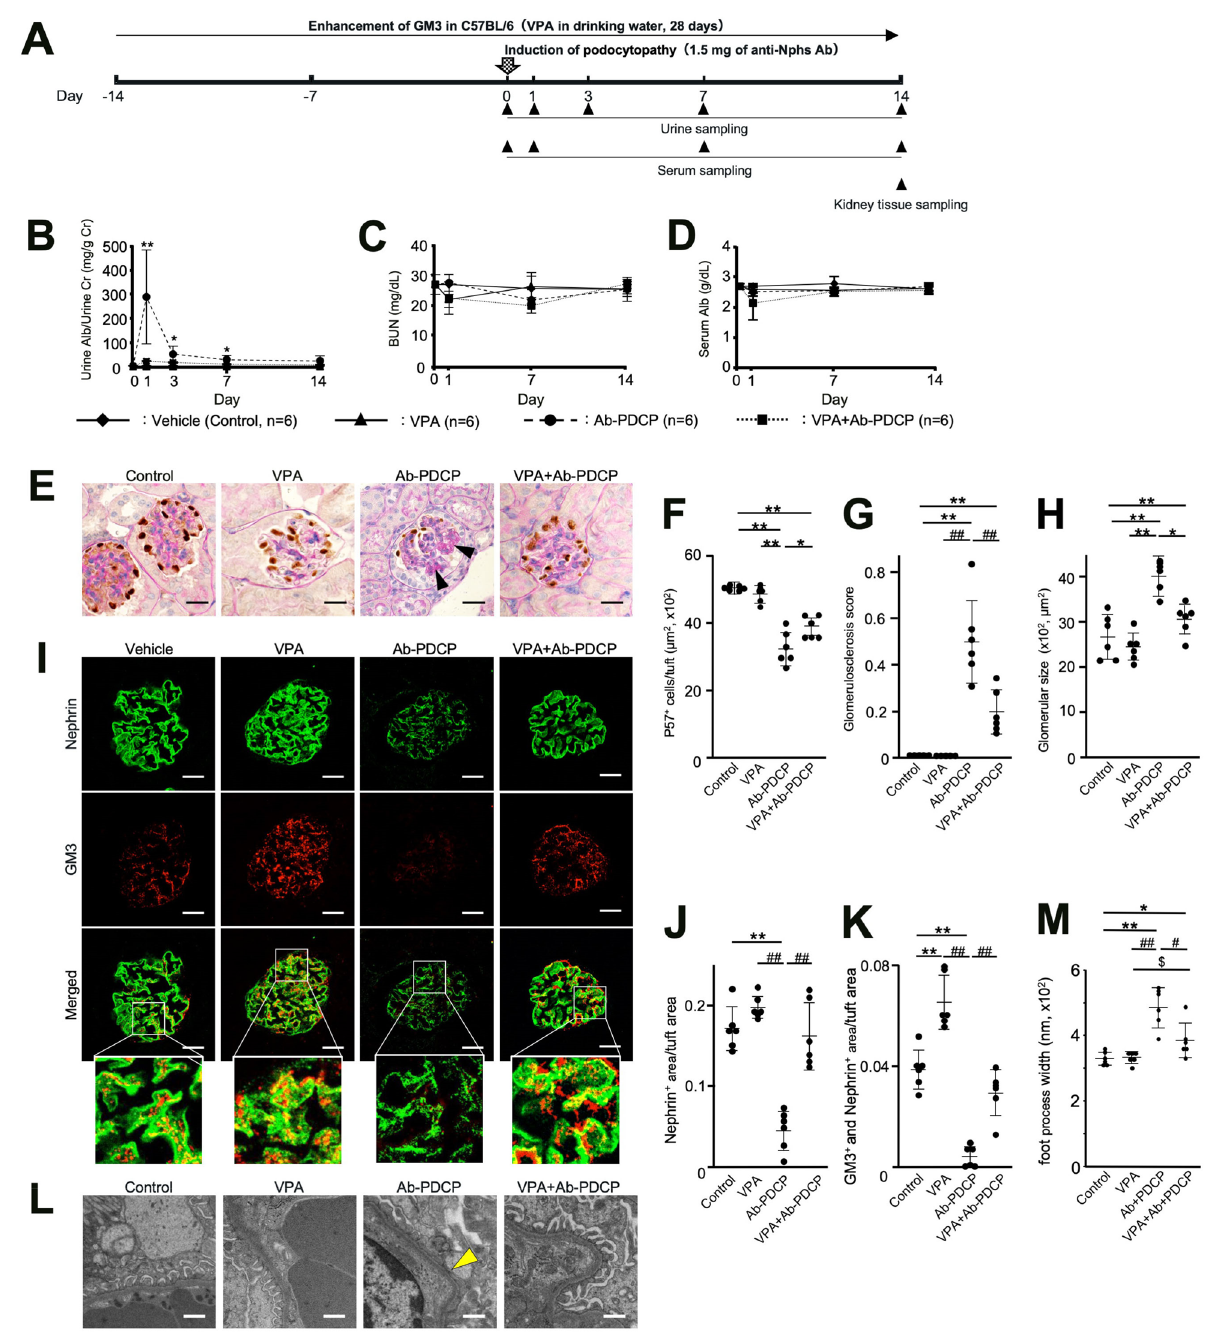
Figure 2. Preventive effect of podocytopathy by GM3 via administration of VPA in anti-nephrin antibody-induced podocytopathy mice. ( A ) Schedule for podocytopathy prevention test using VPA. ( B ) Line graph showing urine albumin to creatinine, ( C ) urea nitrogen (BUN), ( D ) serum albumin. Vehicle (Control), VPA administered mice (VPA), 1.5 mg of anti-nephrin antibody (anti-Nphs Ab)-induced podocytopathy (Ab-PDCP), and VPA + 1.5 mg of anti-Nphs Ab-induced podocytopathy (VPA + Ab-PDCP) mice are shown as a solid line with diamond, a solid line with triangle, dashed line with circle and dotted line with square, respectively. * P < 0.05; ** P < 0.01 vs. control. ( E ) p57 (podocyte marker, brown) and periodic acid-Schiff (PAS) staining of glomeruli. Arrowhead showing glomerulosclerosis. Scale bars: 20 µm. ( F ) Scatter diagram showing p57 + cells/tuft, ( G ) glomerulosclerosis score, and ( H ) glomerular size, respectively. Twenty glomeruli per mouse were analyzed in each dot. * P < 0.05; ** P < 0.01 vs. control, ## P < 0.01 vs. Ab-PDCP. ( I ) Immunofluorescence staining images of glomeruli. Scale bars: 20 µm. Nephrin (green) and GM3 (red) merged areas (yellow) highlighted in enlarged images. ( J ) Scatter diagram showing nephrin fluorescence area/tuft area, ( K ) GM3 and nephrin merged fluorescence area/tuft area. ** P < 0.01 vs. control, ## P < 0.01 vs. Ab-PDCP. ( L ) Images of podocyte foot processes by transmission electron microscopy. Yellow arrowhead showing area of foot process effacement. Scale bars: 10 µm. ( M ) Scatter diagram showing quantification of foot process effacement. * P < 0.05; ** P < 0.01 vs. control, # P < 0.05; ## P < 0.01 vs. Ab-PDCP, $ P < 0.05 vs. VPA. Statistical analyses were performed from mice (n = 6) in each